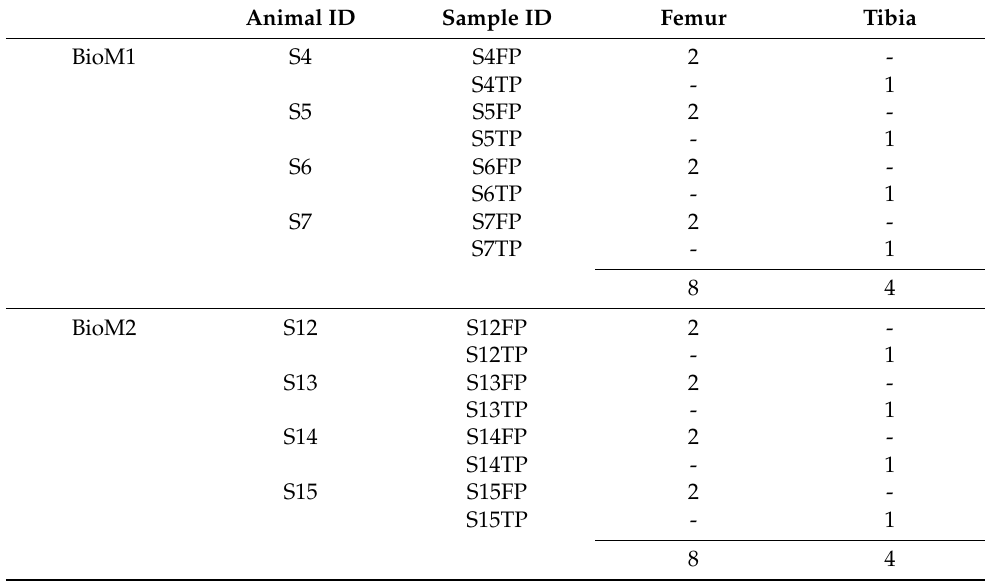
Table 1. Location and total number of bone defects filled with BioM1 or BioM2.